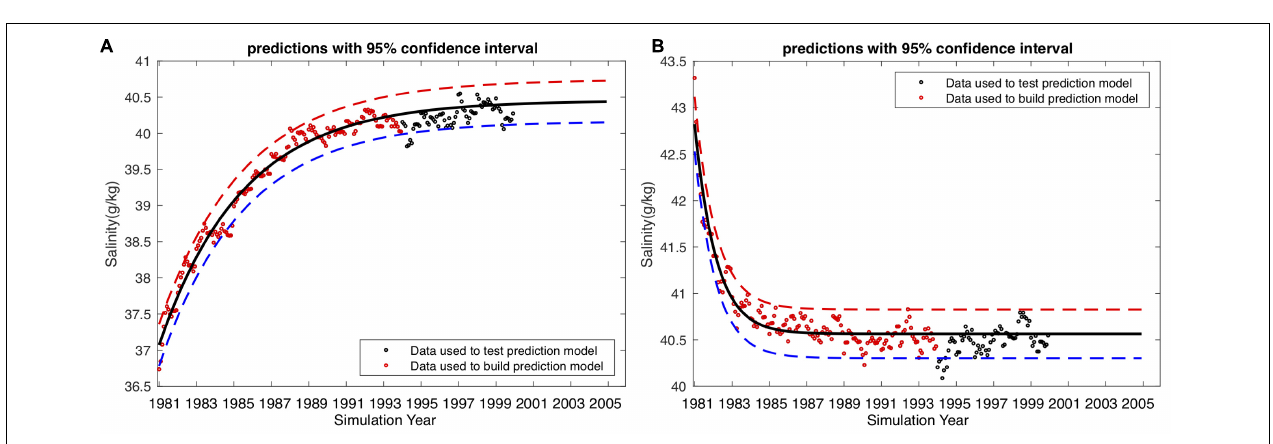
FIGURE 9 | Simulated climatological, depth-average annual mean salinity and corresponding temporal standard deviation: (A,B) Ic1 experiment (1981–1990). (C,D) D1b experiment (1990–1999). Note that the large standard deviation in the northwestern Gulf is a consequence of the Tigris and Euphrates Rivers freshwater discharge into this region.